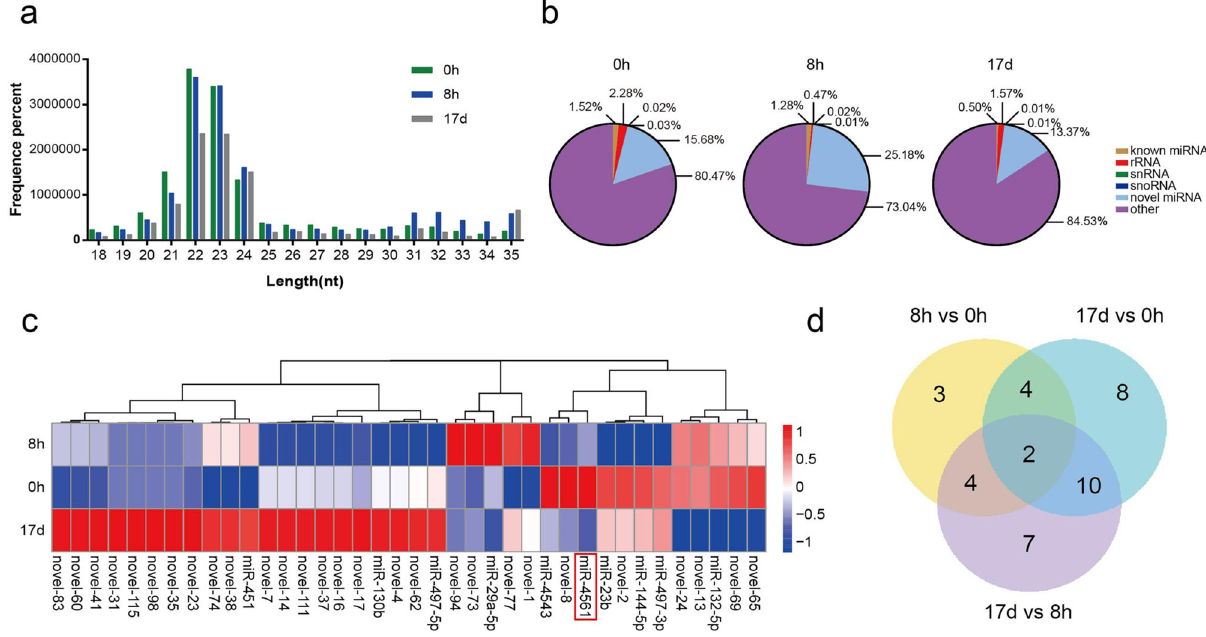
Fig. 1 Illumina sequencing analysis of miRNA expression in lamprey following bacterial infection. a Length distribution of the RNA reads in the three libraries (0 h, 8 h, and 17 d). b Small RNA type composition. c Cluster map of miRNA differentially expressed in the three groups. d Venn diagram of differentially expressed miRNAs in the following comparisons: 8 h vs 0 h, 17 d vs 0 h, and 17 d vs 8 h.